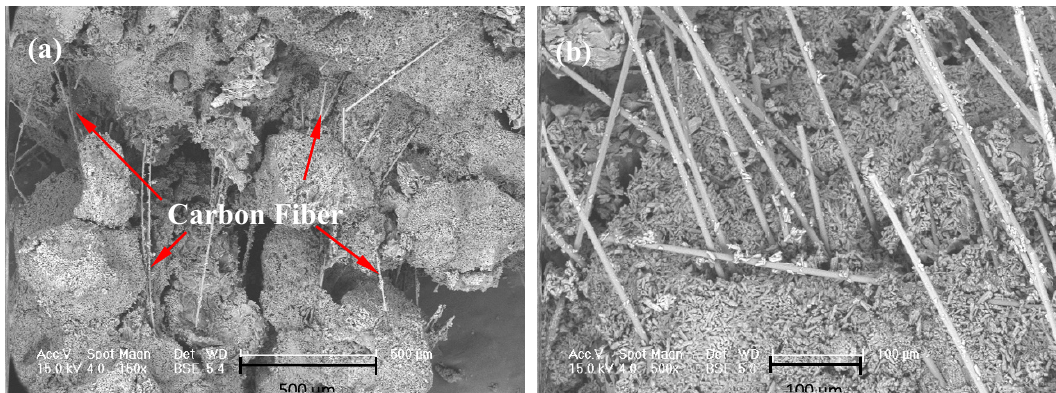
Figure 12. The morphology of gypsum: ( a ) Before thermal cycling; ( b ) after thermal cycling.